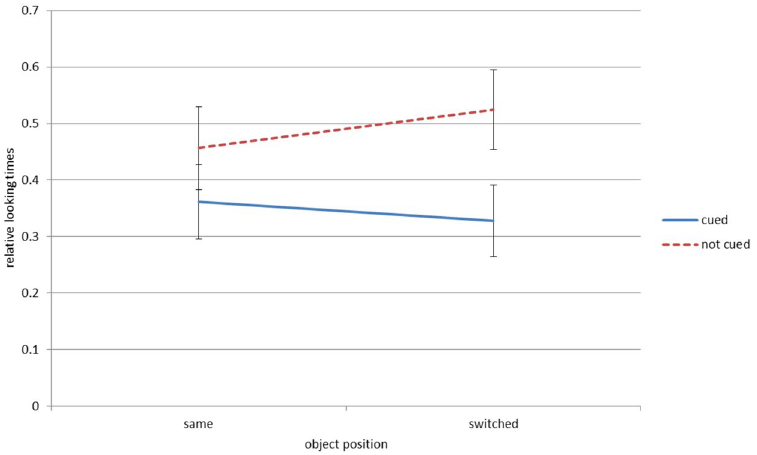
Figure 4. Natural-contrast condition: graphs of the mean relative looking times for the previously cued and not-cued objects in trials with objects staying at the same position or switching positions. Error bars represent 95% confidence intervals.